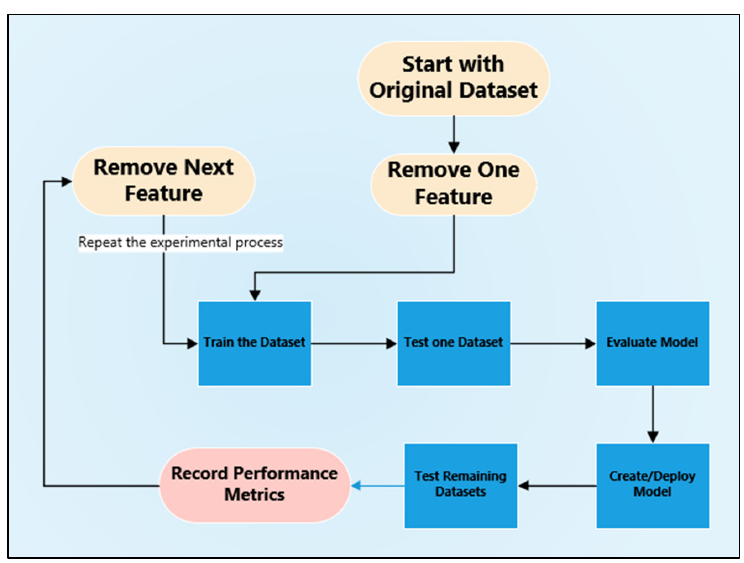
Figure 8. Flow diagram showing the feature redaction process.